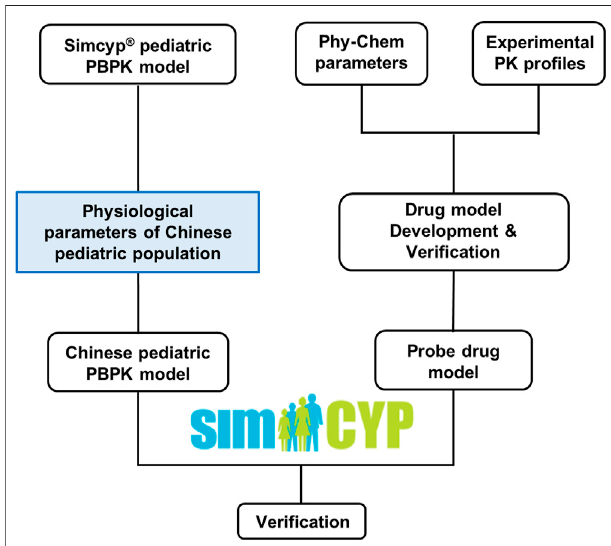
FIGURE 1 | The general